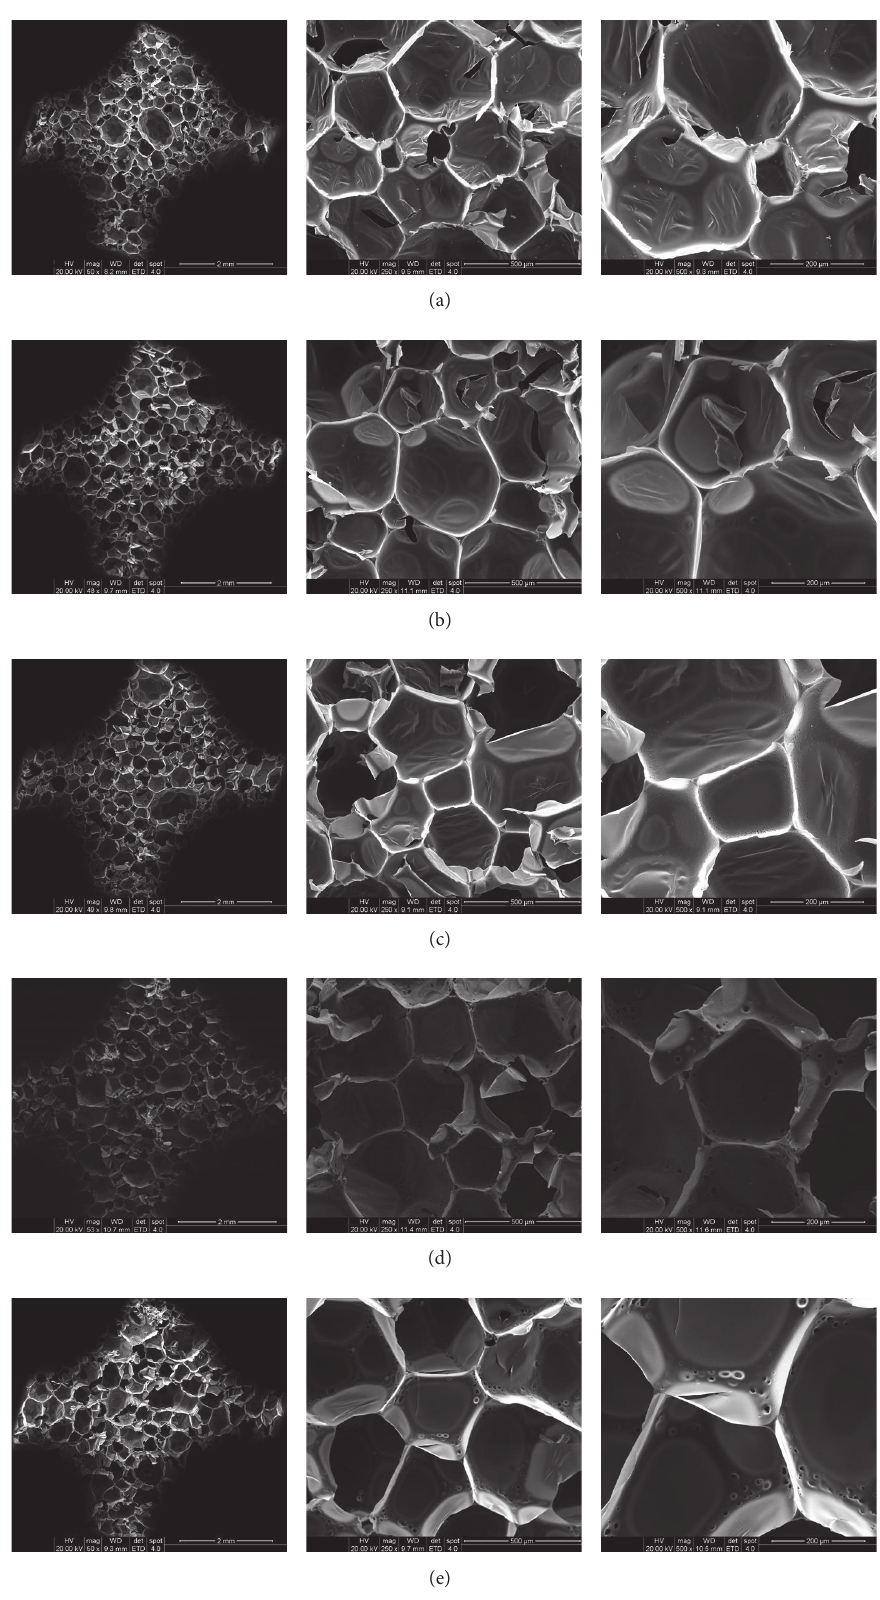
Figure 6: SEM photos of PG samples ((a) 10%, (b) 30%, (c) 50%, (d) 80%, and (e)